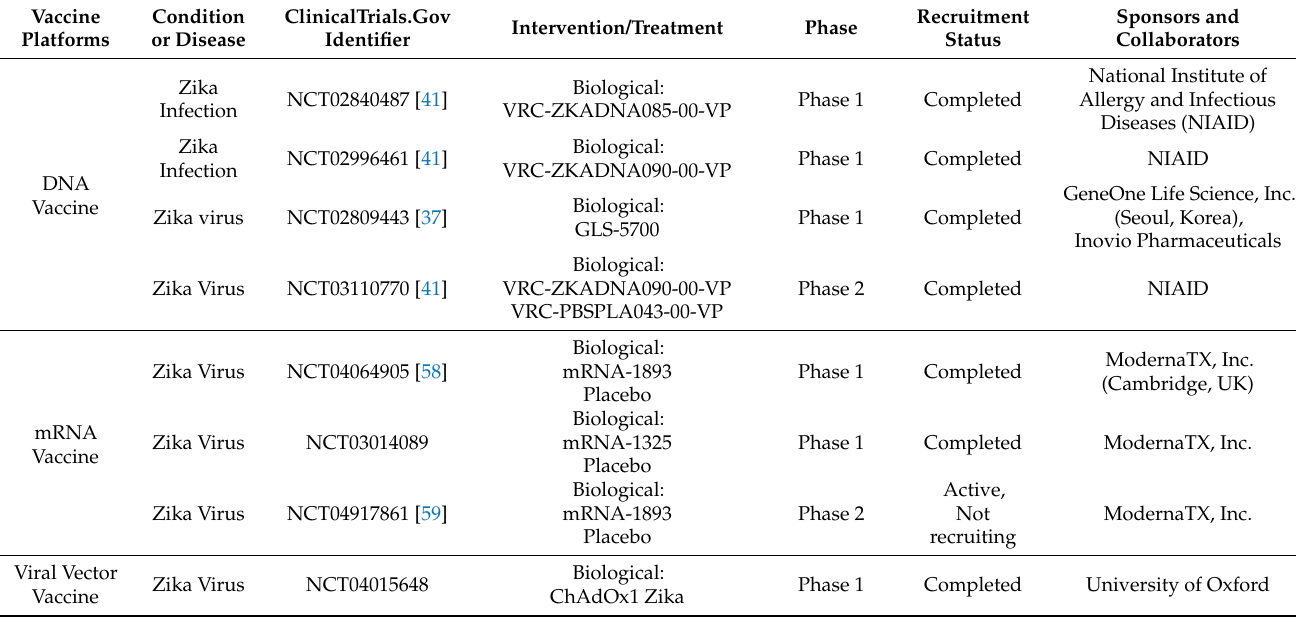
Table 1. Vaccine candidates on different vaccine platforms in clinical